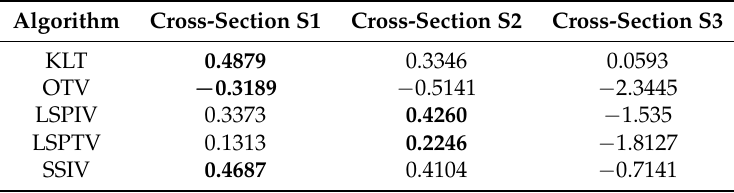
Table 5. Nash–Sutcliffe results for Video B. Bold text represents the best recorded value for each